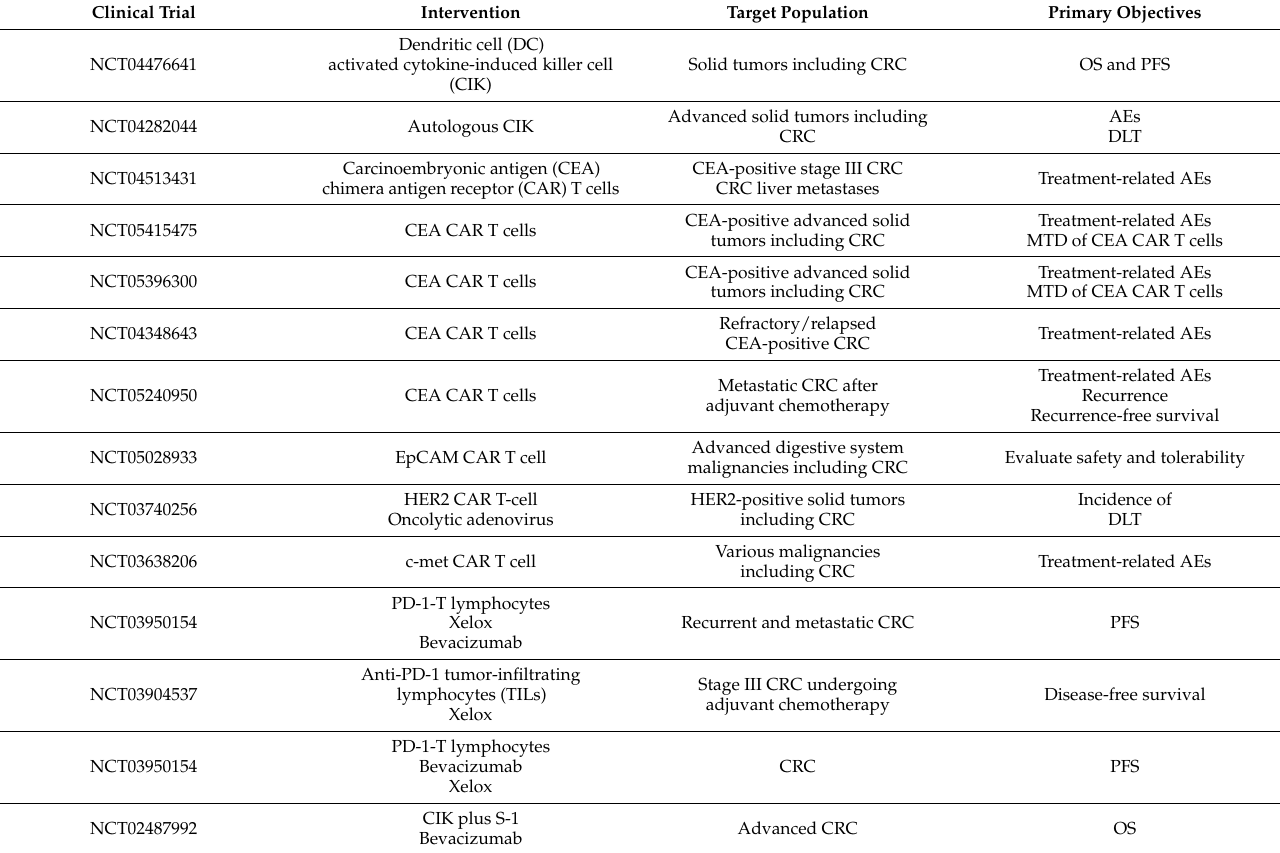
Table 2. Clinical trials evaluating the use of adoptive cell transfer therapy (ACT) in CRC. Clinical Trial Intervention Target